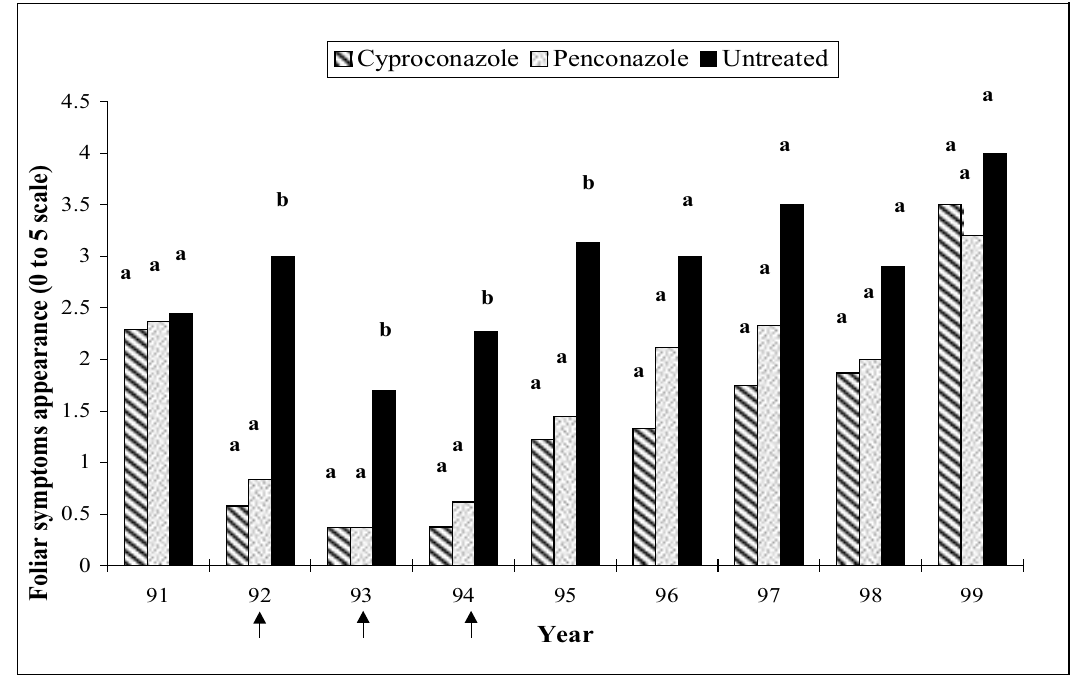
Fig. 2. Injector-pole field trial (cv. Sangiovese). Black arrow means fungicide application; values marked with the same letter are not statistically different ( P =0.05) according to Duncan’s multiple